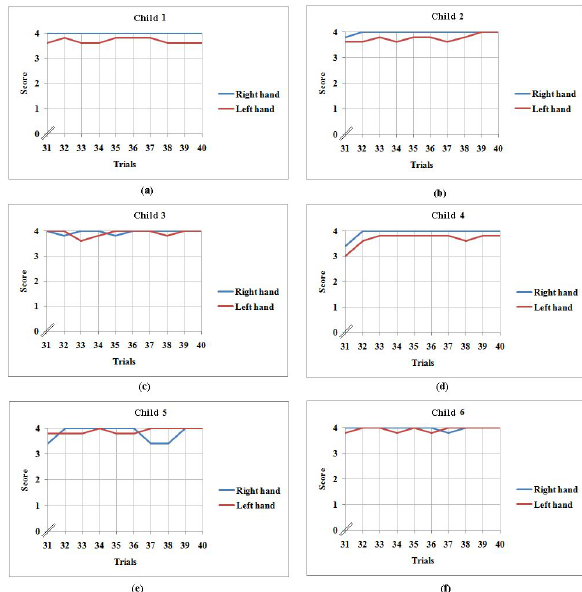
Figure 5: Assessment curves of the children for last ten trials.